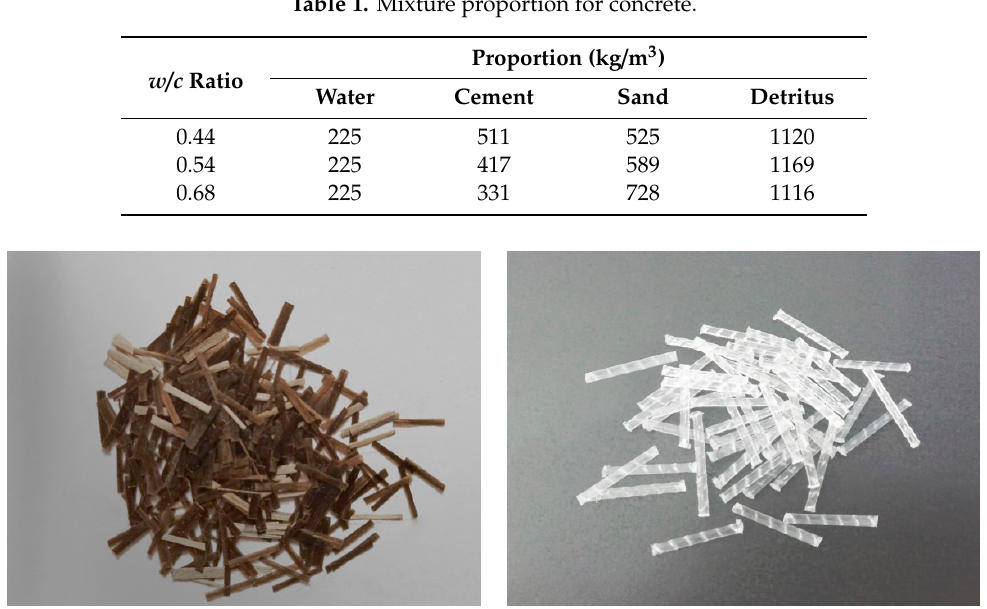
Table 1. Mixture proportion for concrete.